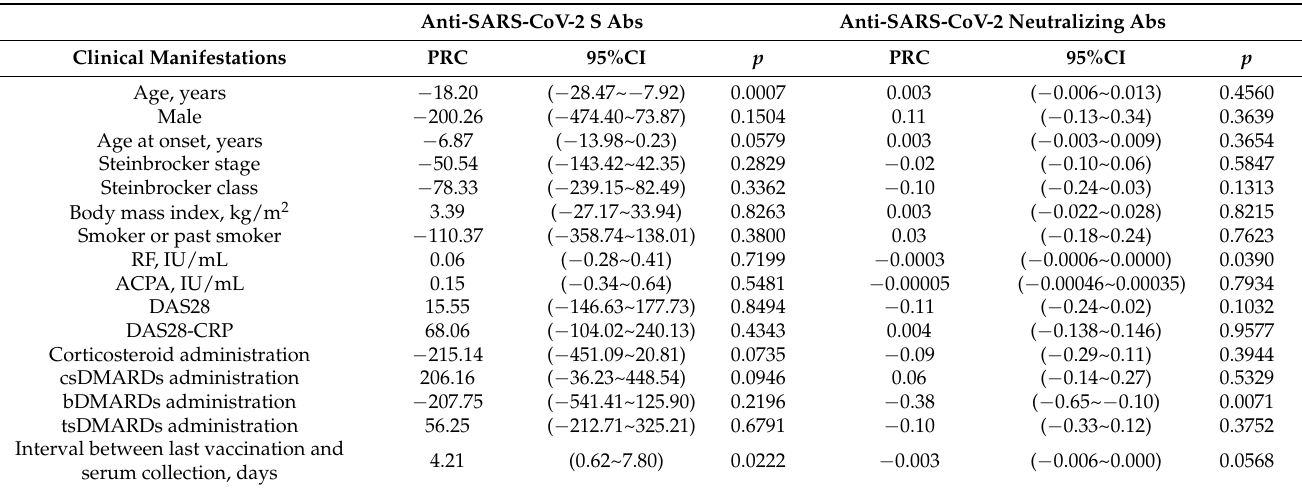
Table 3. Correlations of clinical manifestations and anti-SARS-CoV-2 Abs in RA. Anti-SARS-CoV-2 S Abs Anti-SARS-CoV-2 Neutralizing